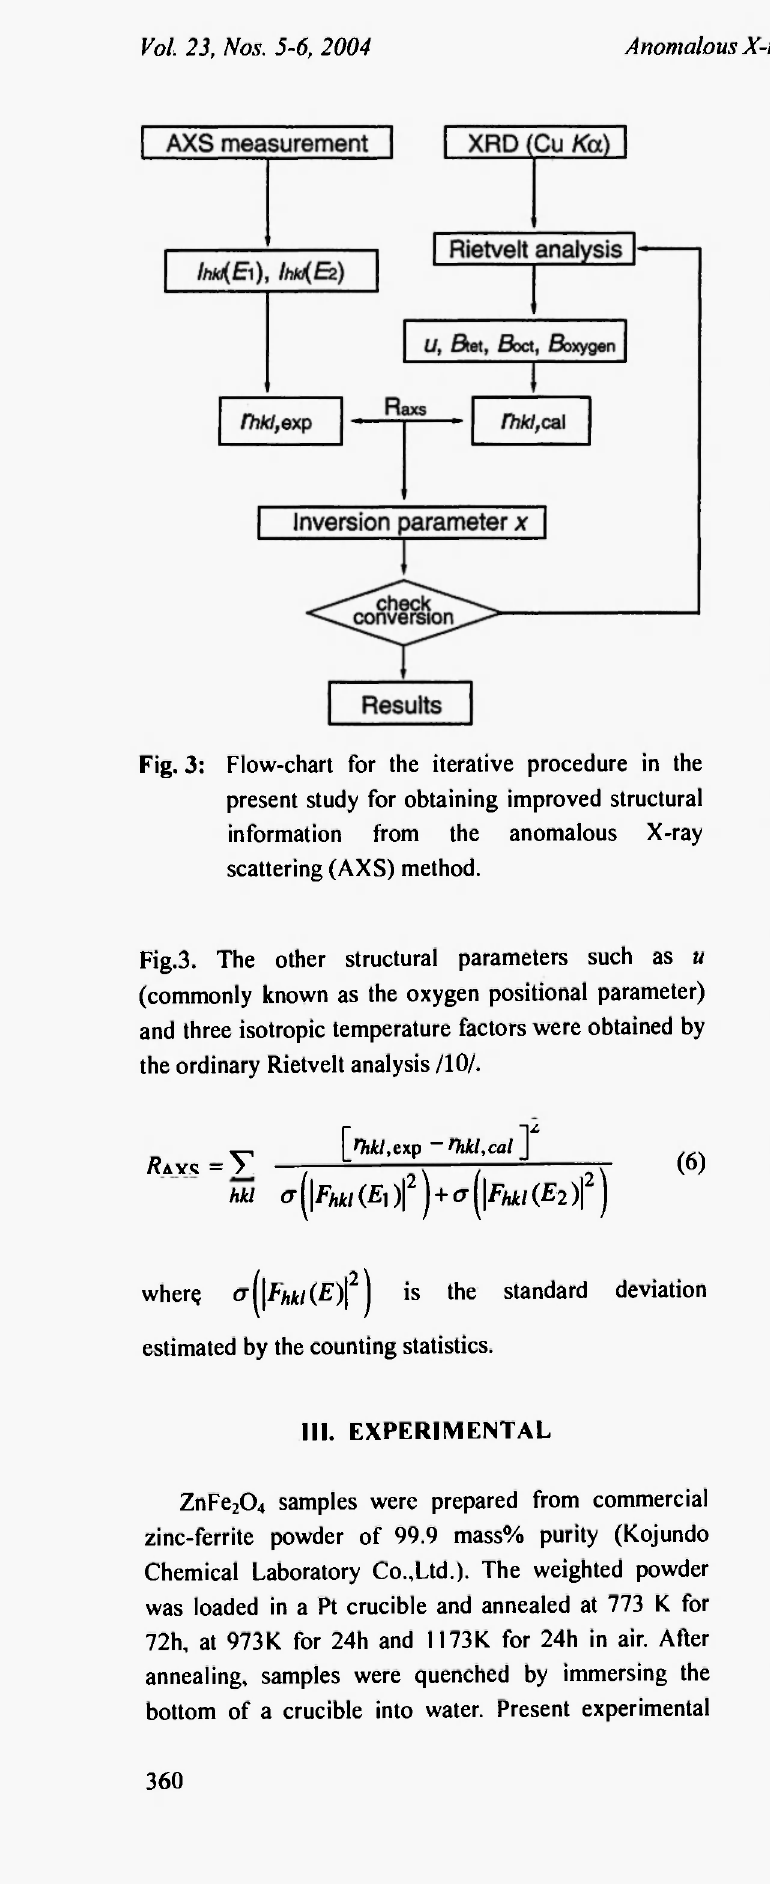
Fig. 3: Flow-chart for the iterative procedure in the present study for obtaining improved structural information from the anomalous X-ray scattering (AXS) method.